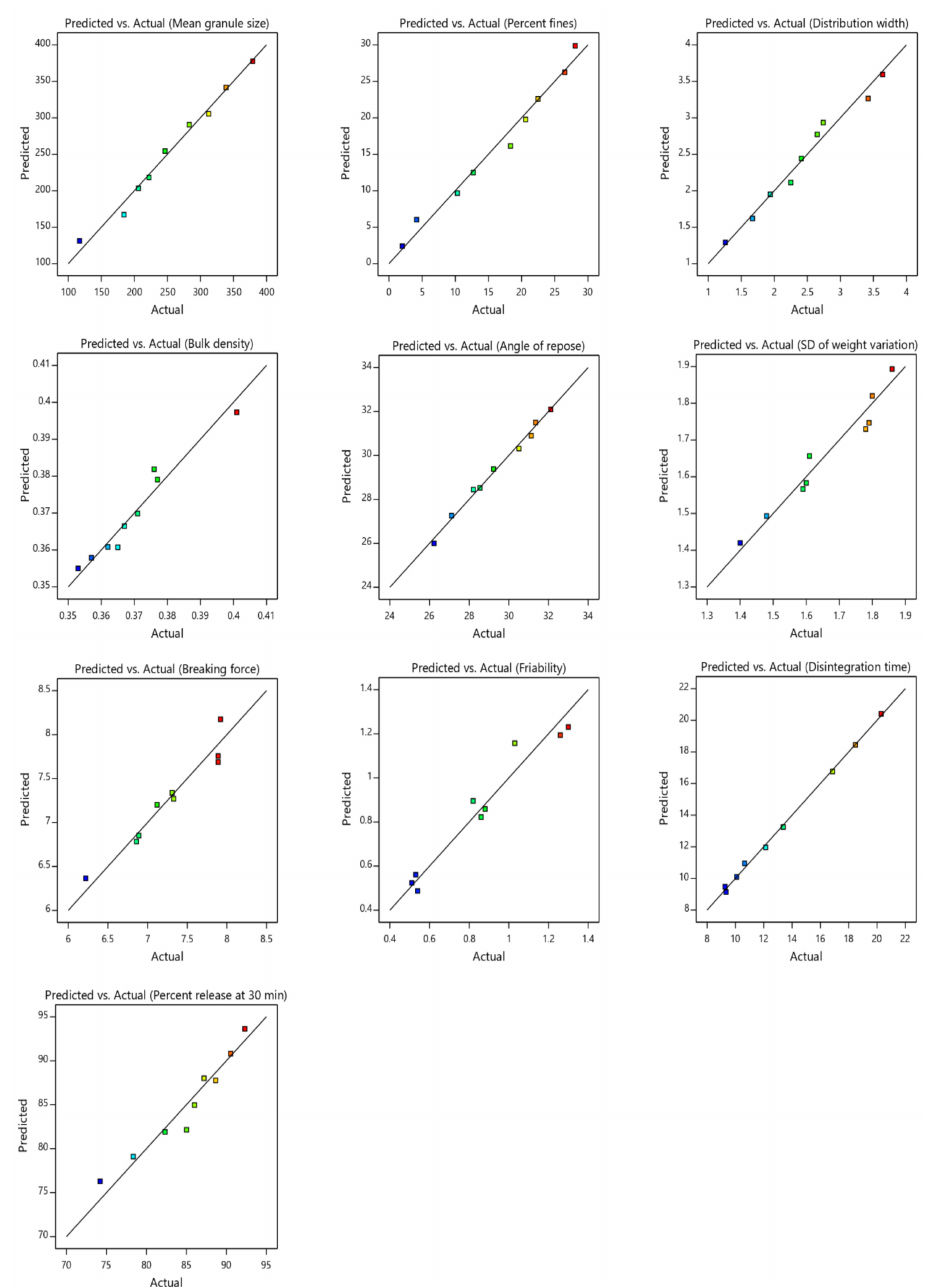
Figure 1. Linear correlation plot relating mean granule size, percent fines, distribution width, bulk density, angle of repose, SD of weight variation, breaking force, friability, disintegration time and drug release at 30 min, between the predicted and the measured (actual) values. SD: standard